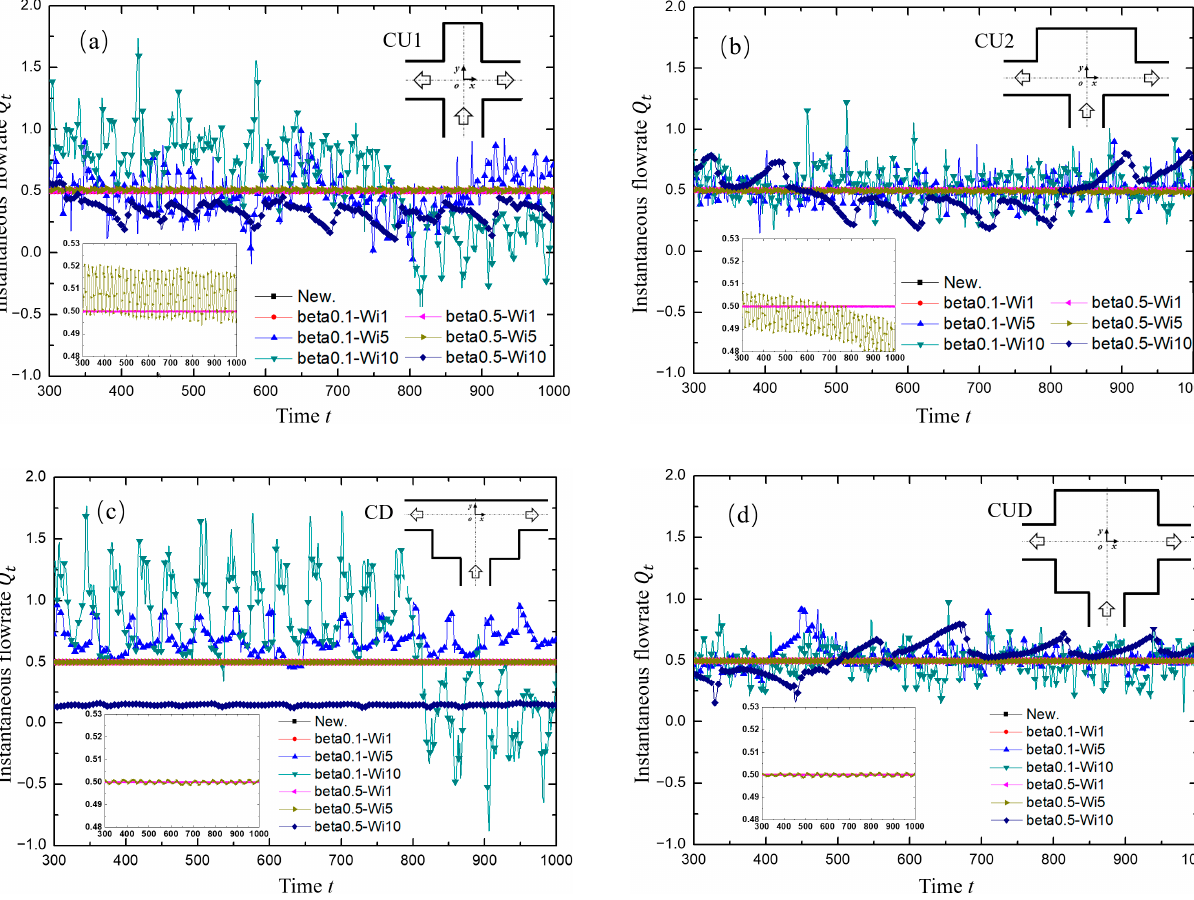
Figure 8. The variation of instantaneous flow rate Q t at the left outlet for different modified T-channel structures with dimensionless time. ( a ) CU1 structure; ( b ) CU2 structure; ( c ) CD structure; ( d ) CUD structure. Inset: For the cases of Newtonian fluid, beta0.1-Wi1, beta0.5-Wi1 and beta0.5-Wi5, the y -axis ranges are set to 0.48 to 0.53 to display more clearly, where the former three cases are nearly collapsed into a line with a value of 0.5.